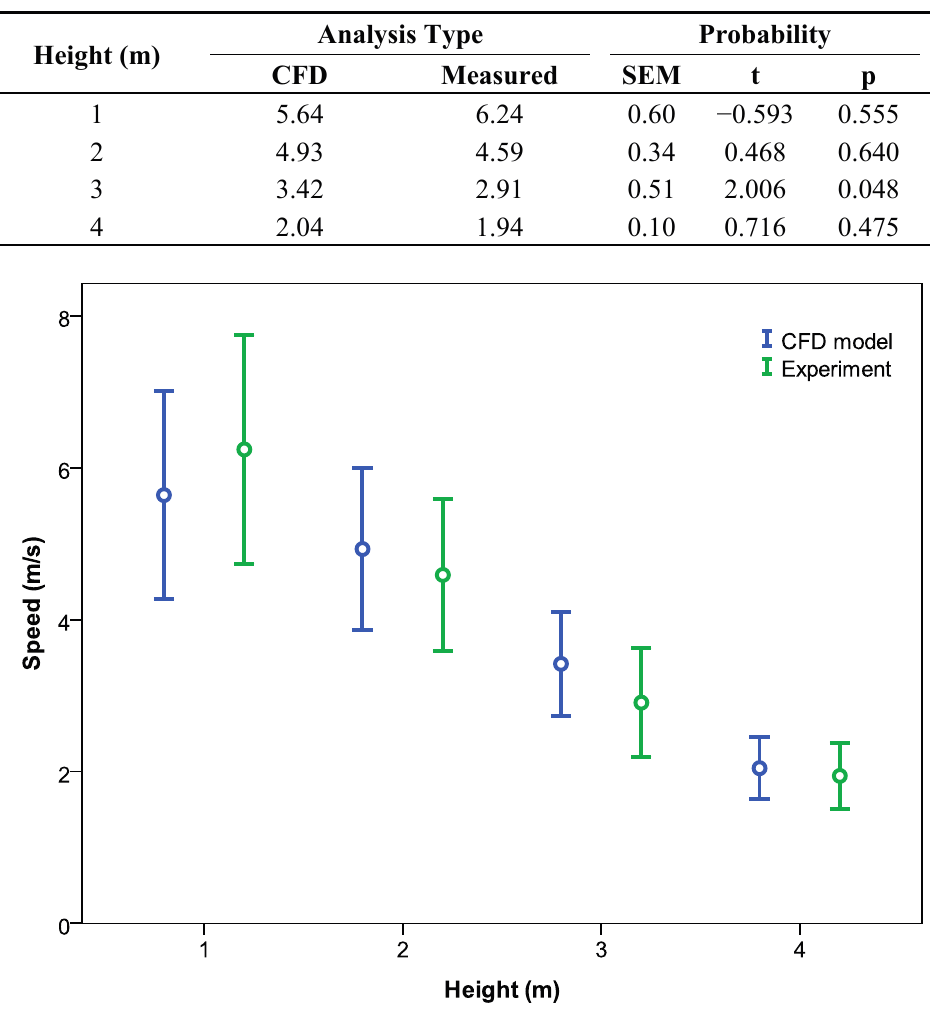
Figure 12. 95% confidence interval of means of air velocity values according to analysis type and